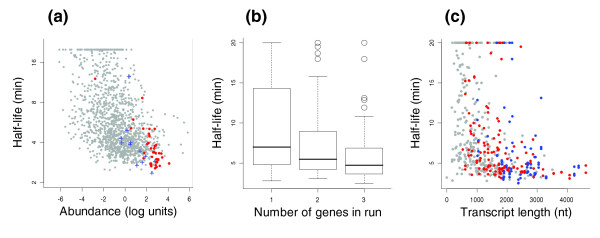
mRNA half-life in relation to transcript abundance, operon size (in number of genes) and transcript length (in nucleotides) in S. solfataricus. (a) Scatter plot of transcript abundance versus half-life. mRNA half-lives are shown in log2-scale. Transcript abundance represents log2-transformed expression (cDNA/genomic DNA) ratios, normalized such that the average of the log ratios equals zero. Red and blue dots represent genes for ribosomal proteins and polymerase subunits, respectively. (b) Box plots of half-life distributions for transcripts in one-, two- and three-gene runs; 50% of the genes are included in the boxes, and 80% between the whiskers; the line within the box represents the median half-life. (c) Scatter plot of mRNA half-life versus transcript length (counting from first start to last stop codon in each run). Genes belonging to one-, two- and three-gene runs are shown in grey, red and blue, respectively.